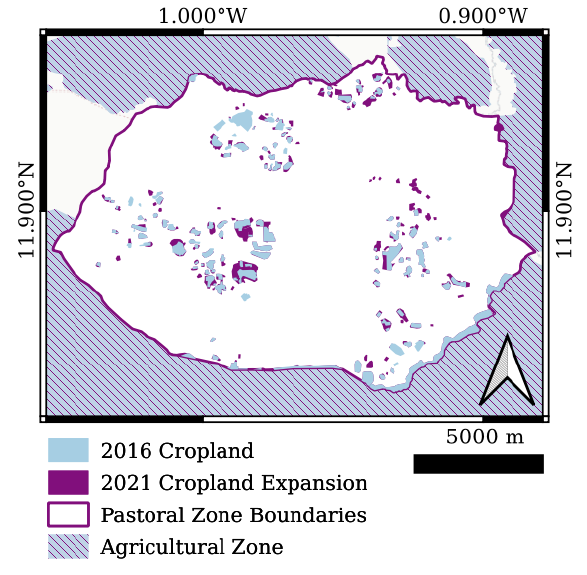
Figure 8: Cropland changes in the Sondre-Est Pastoral Zone be- tween 2016 and 2021 , EPSG 4326